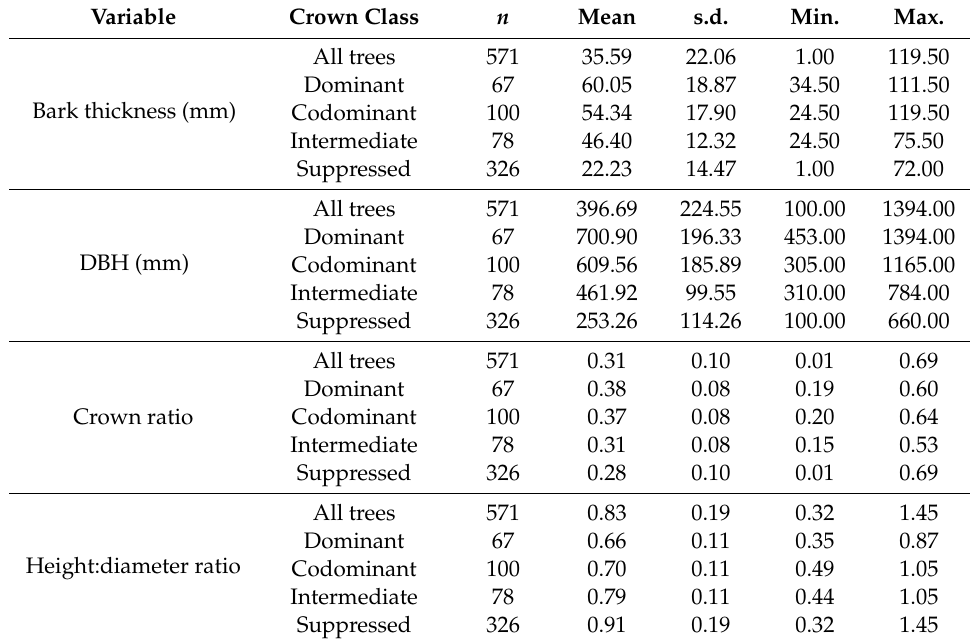
Table 3. Summary data for redwood trees in each crown class in three even-aged stands at age 85–100 years in Jackson Demonstration State Forest.